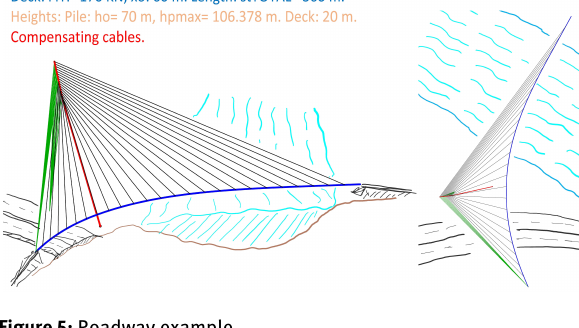
Figure 5: Roadway